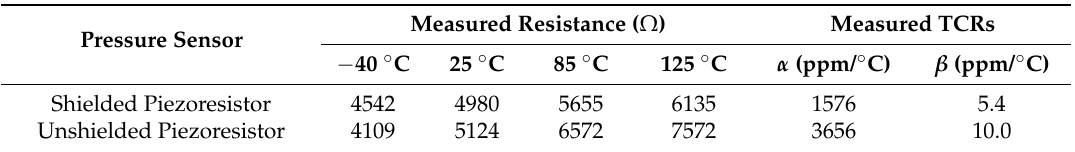
Table 5. Test data and calculated TCRs.